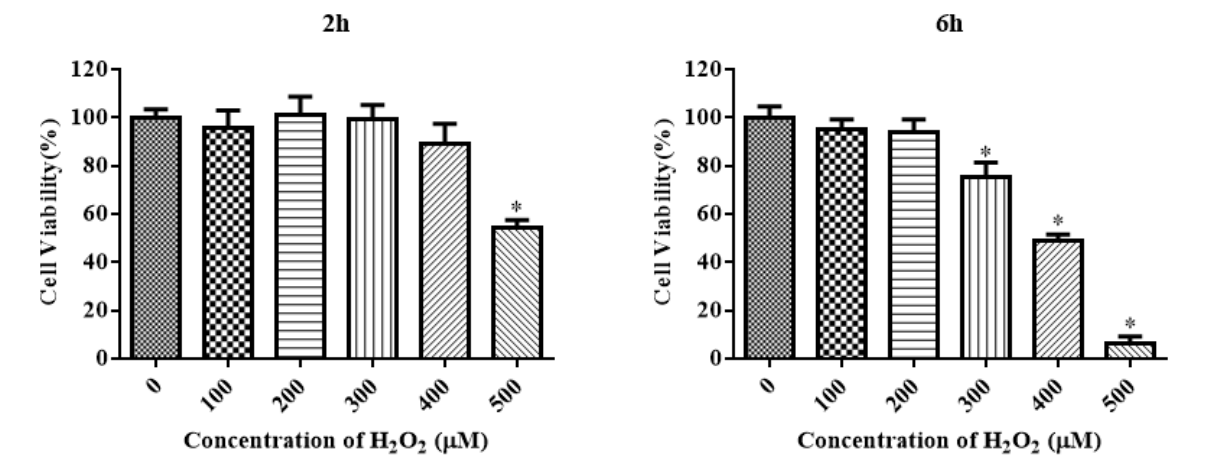
Figure 3. The IDECs were treated with various concentrations and incubation times of H 2 O 2 (0–500